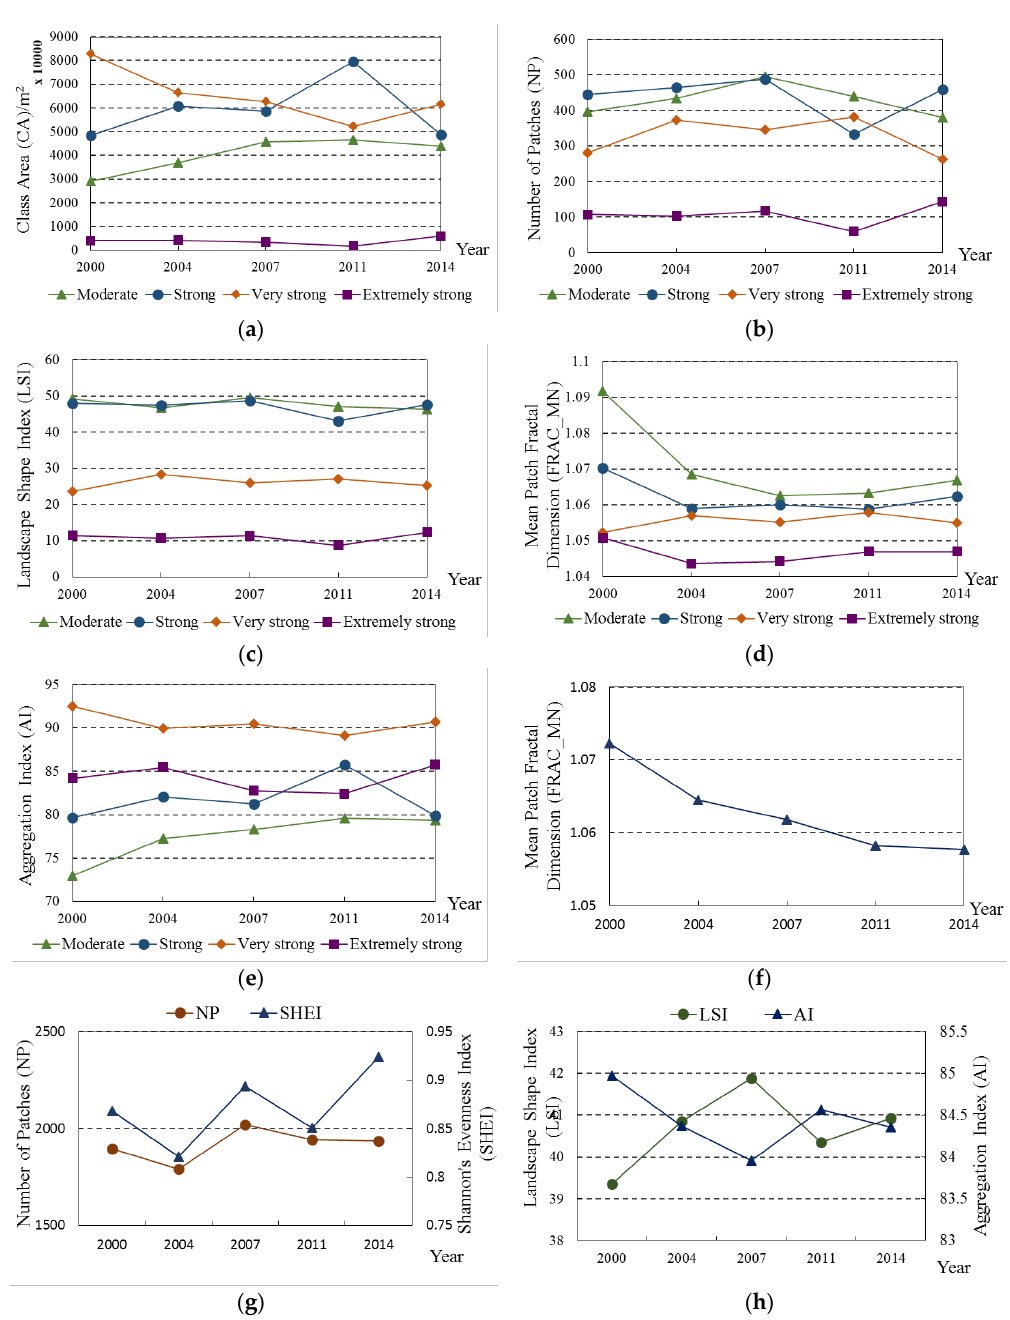
Figure 3. Chart of UHI intensity indices. ( a ) The total area, and ( b ) total number of each type of patch; ( c ) the landscape regular shape, and ( d ) the aggregation of each type, respectively. The higher the value of LSI, the larger the degree of more irregular shaped patches, but the greater value of AI indicates a higher degree of aggregation. ( e ) Represents the complexity of the patch border shape, with larger values indicating more complex shapes; ( f – h ) represent the dynamic change of total landscape structures for all five time periods, of which SHEI represents the non-uniformity of patch distribution. The SHEI with values of 1 indicates the uniform distribution of different patches.